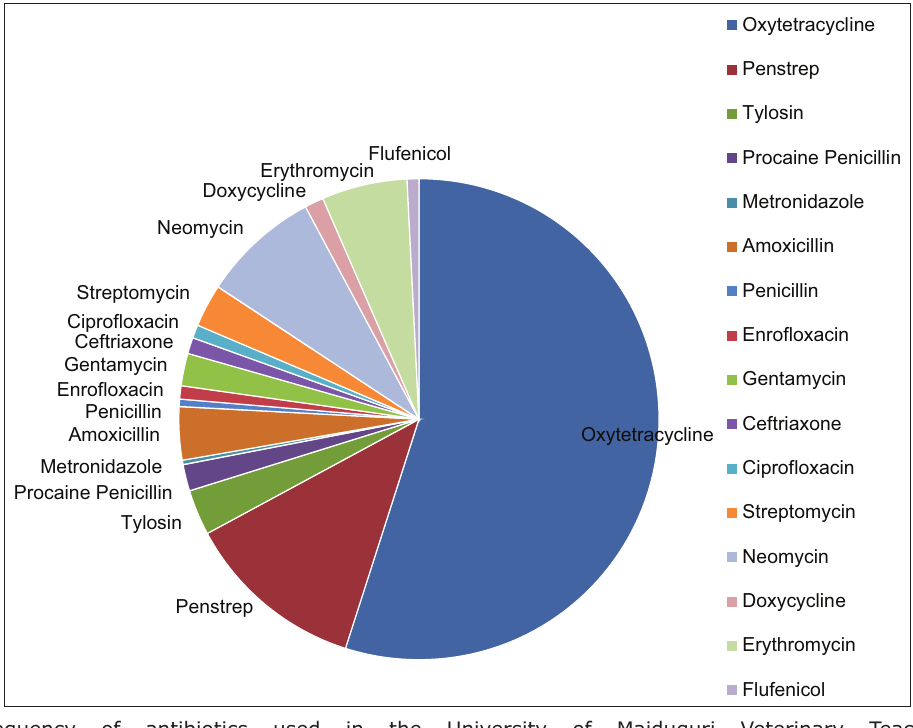
Figure-1: Frequency of antibiotics used in the University of Maiduguri Veterinary Teaching